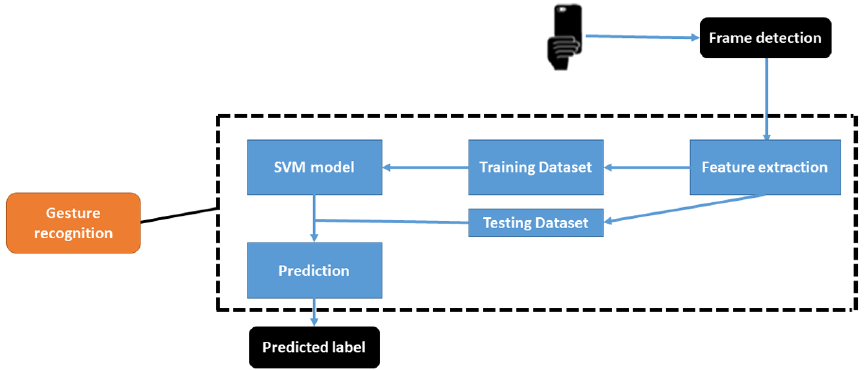
Fig. 1. The flowchart of the